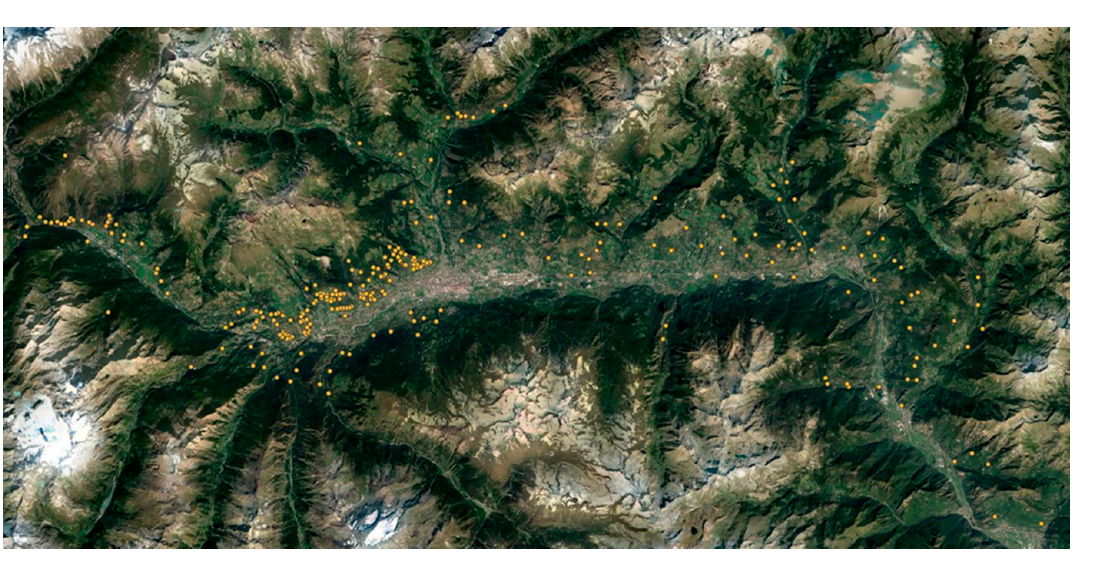
Figure 1. Map of the surveyed area in the Aosta Valley (north-western Italian Alps), showing the georeferenced pheromone baited traps placed in